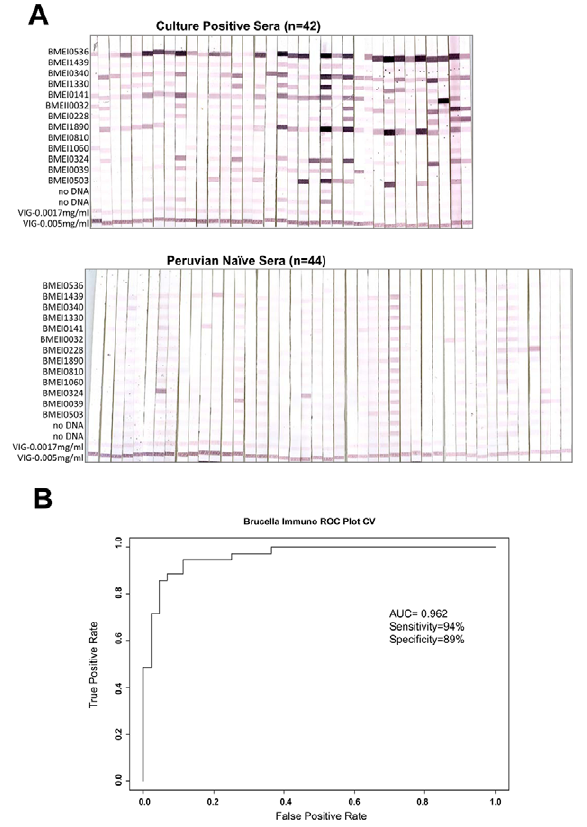
Figure 5. Immunostrips probing. (a)Thirteen serodiagnostic anti- gens were printed onto nitrocellulose paper in adjacent stripes using a BioDot jet dispenser as described in Materials and Methods. Strips were probed with Culture Positive or Peruvian naive sera diluted 1/200 followed by alkaline phosphatase conjugated secondary antibody and enzyme substrate. Weak reactivity in the naı¨ve healthy controls can be distinguished from the strong reactivity in infected group. (b). The LOOCV ROC curve was generated and sensitivity and specificity of immunostrips probing test is 94% and 89%, respectively.